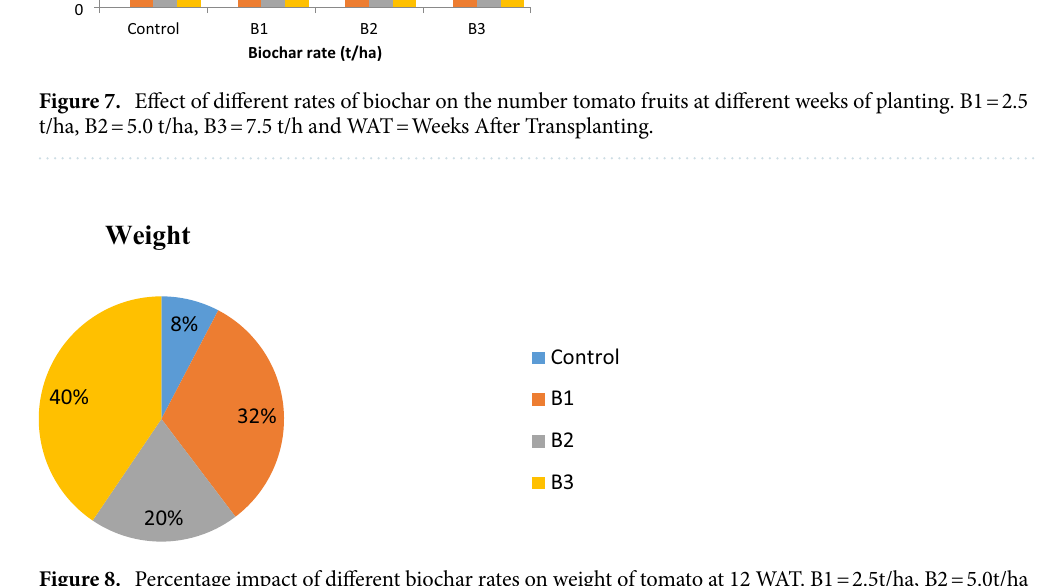
Figure 8. Percentage impact of different biochar rates on weight of tomato at 12 WAT. B1 = 2.5t/ha, B2 = 5.0t/ha and B3 =